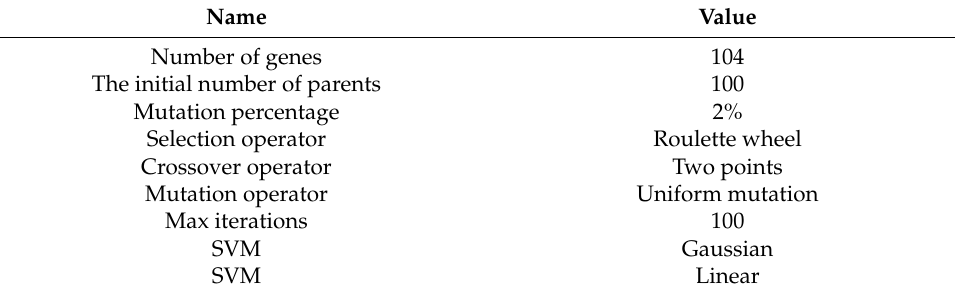
Table 9. Initial parameters used for genetic